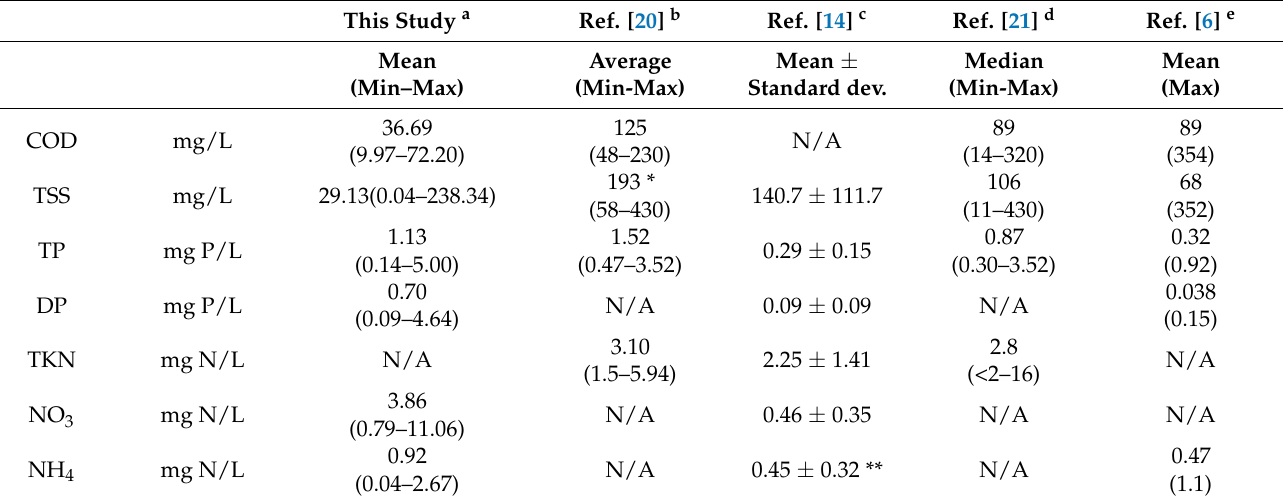
Table 4. Stormwater quality